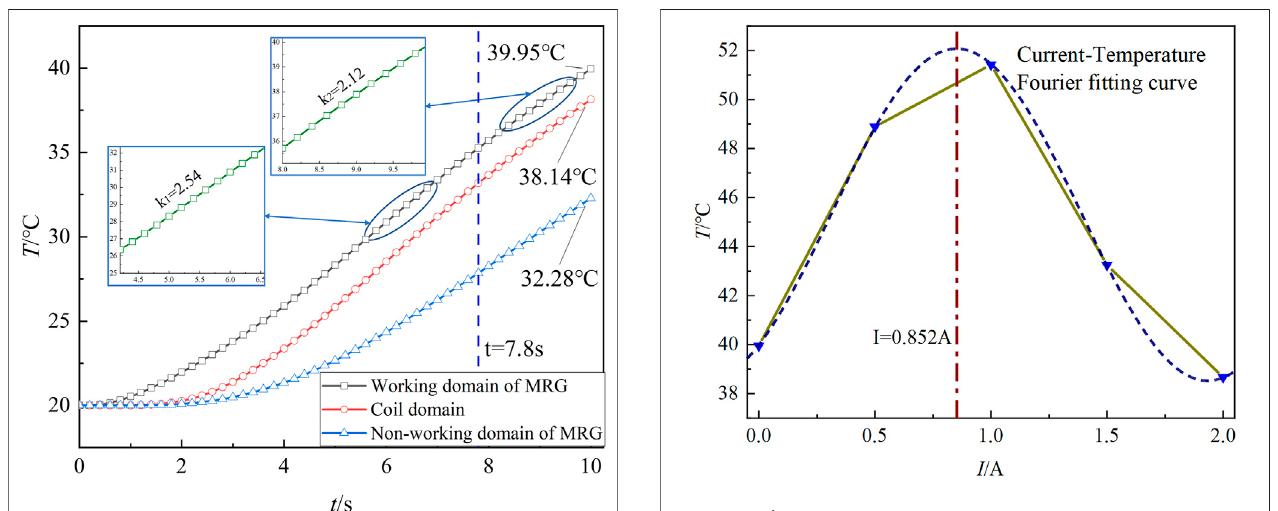
FIGURE 15 | Current – temperature